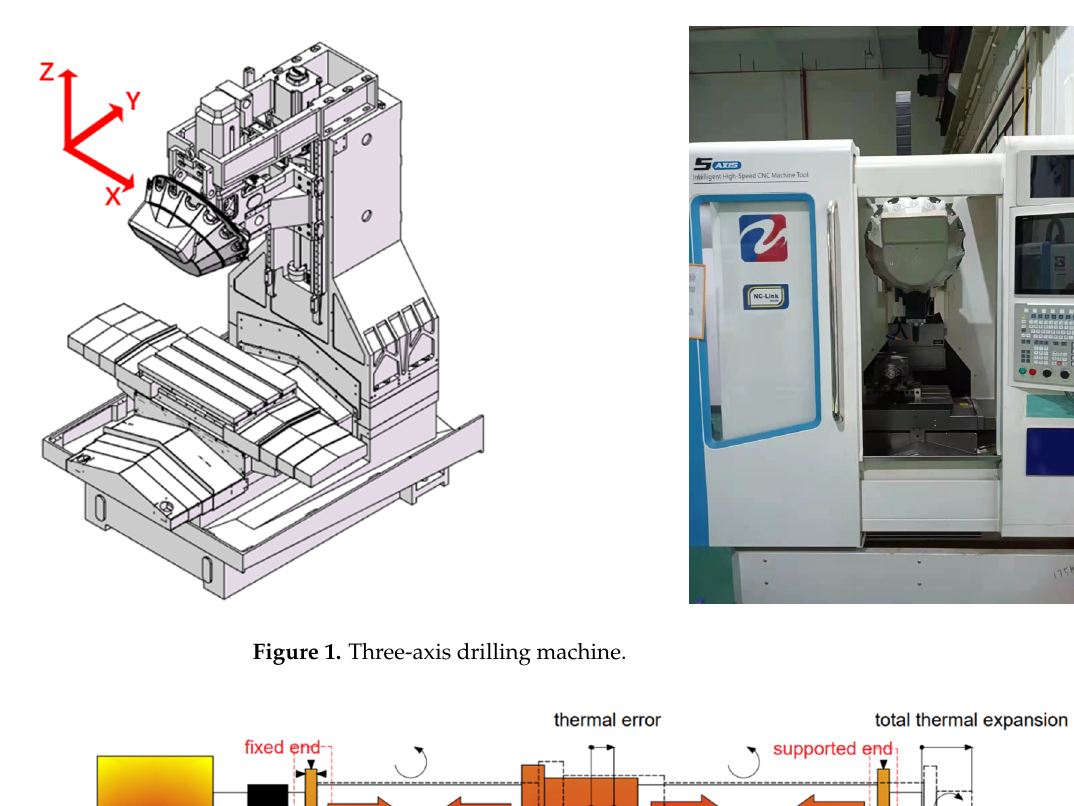
Figure 1. Three-axis drilling machine.